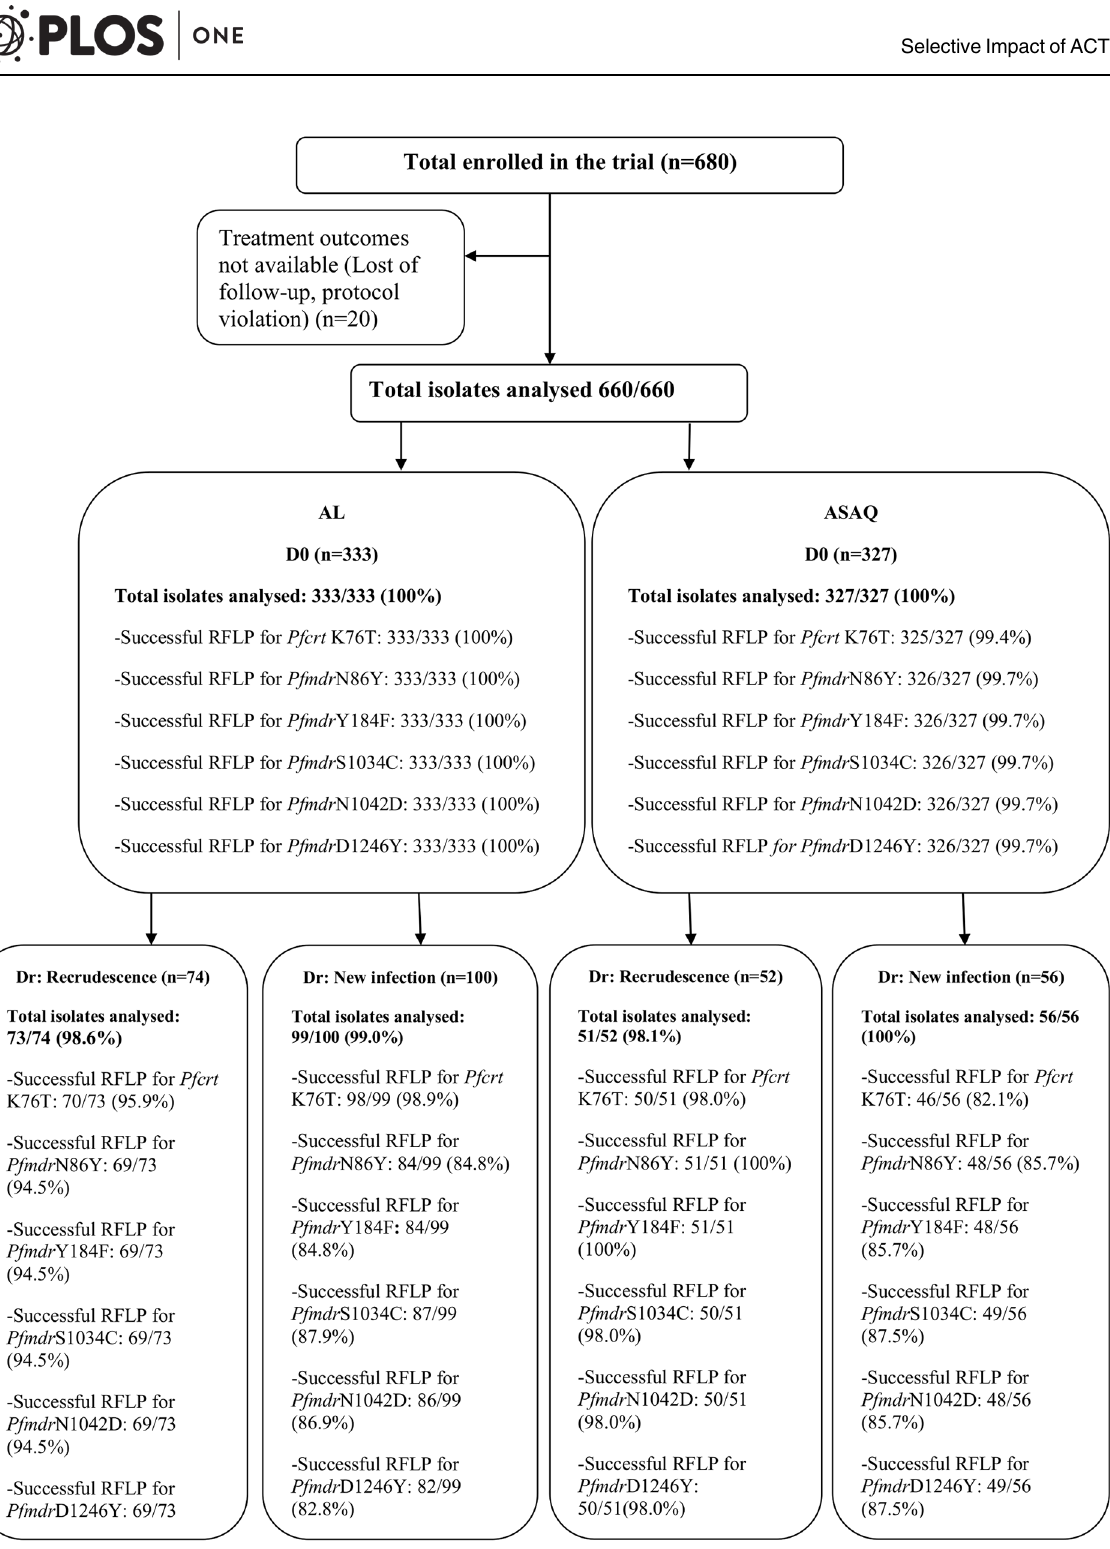
PLOS ONE | DOI:10.1371/journal.pone.0151565 March 31,